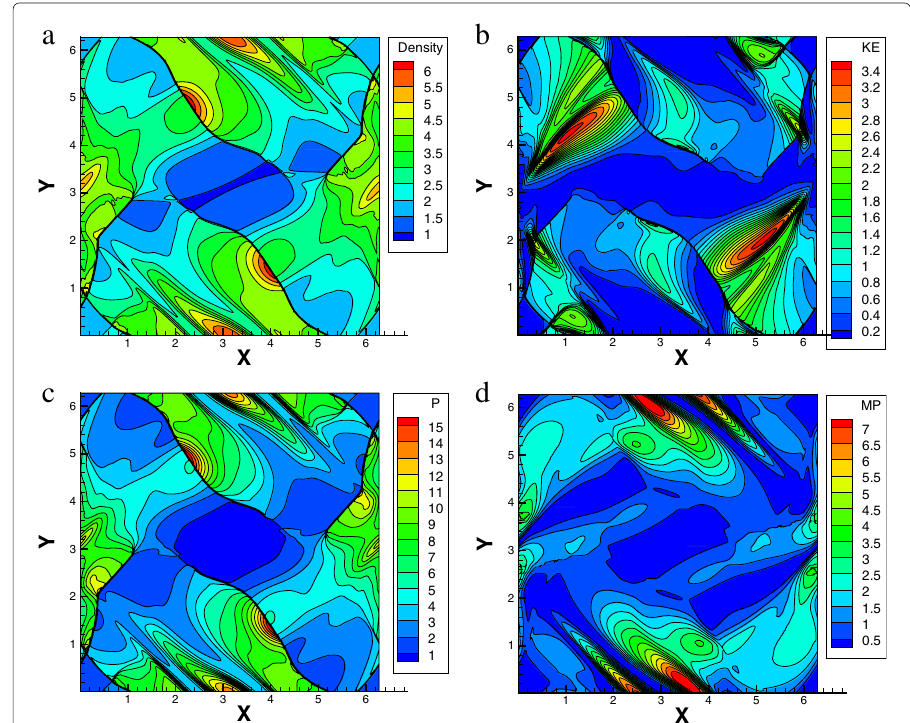
Fig. 15 The UGKWP results of the multiscale Orszag-Tang vortex problem with Kn 10 4 and r